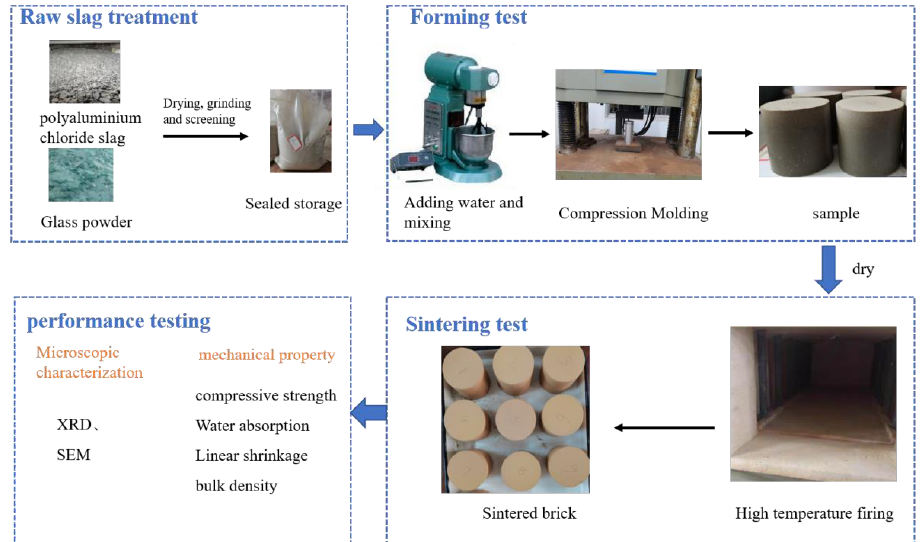
Figure 1. Preparation process of sintered brick.